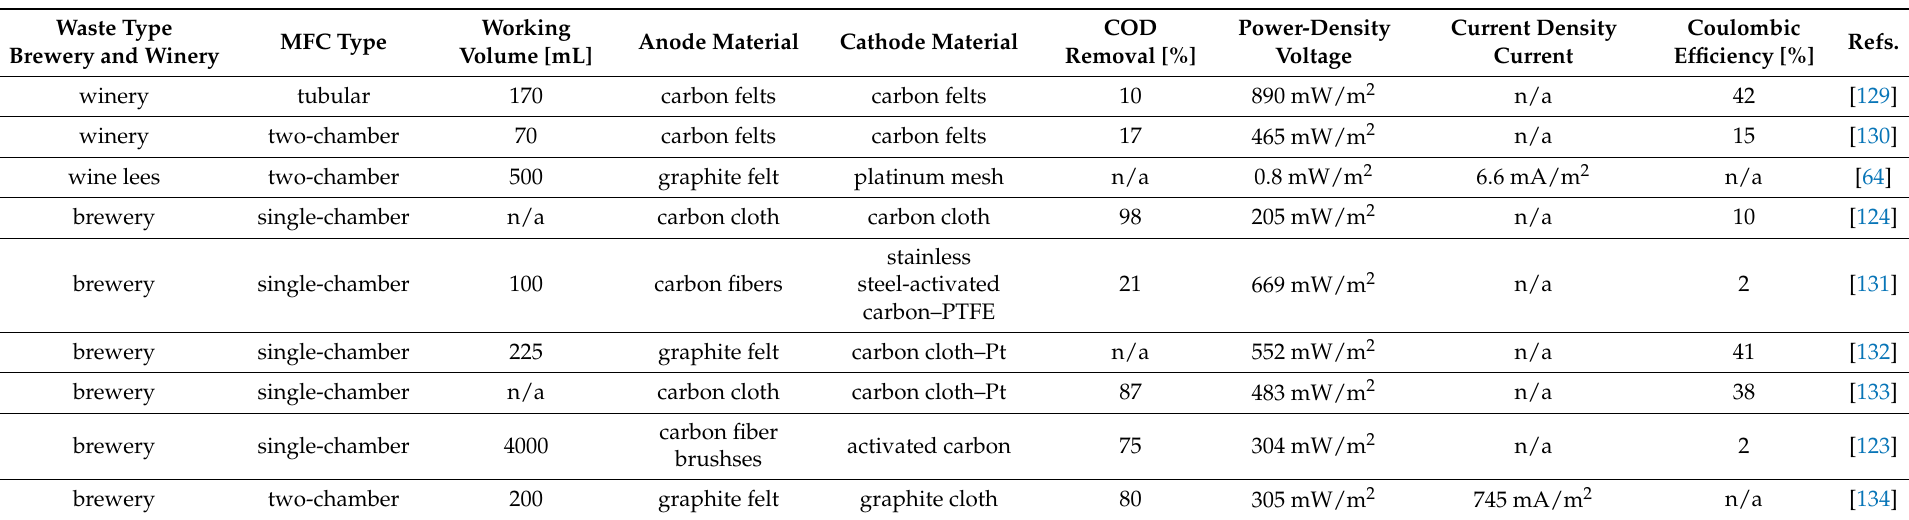
Table A4. Summary of studies reporting use of brewery and winery waste in